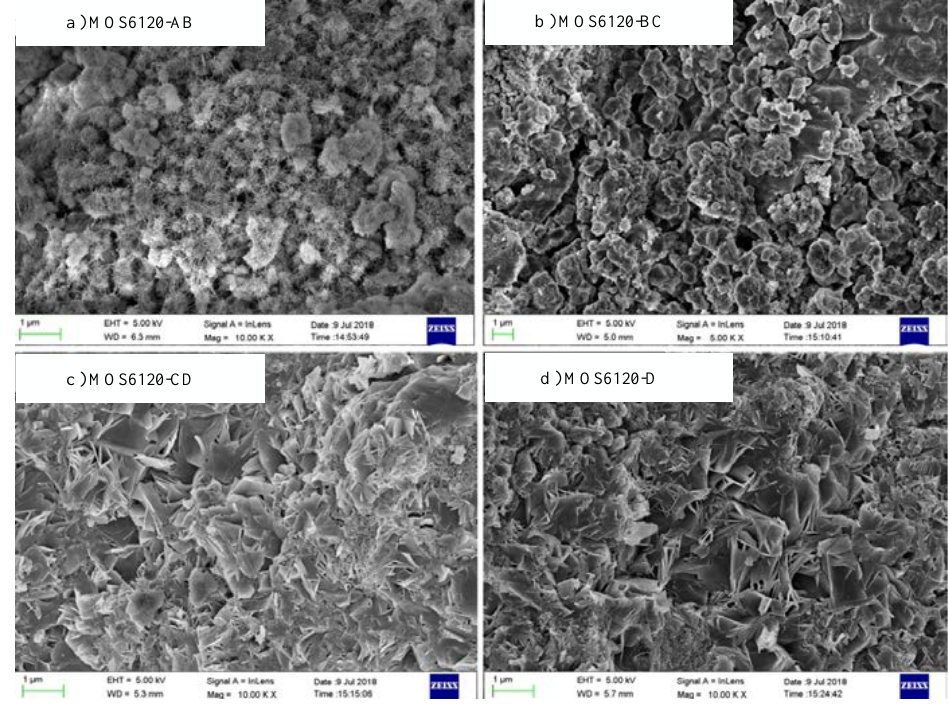
Figure 12. Pore change diagram of samples at different time points on a microscopic level.